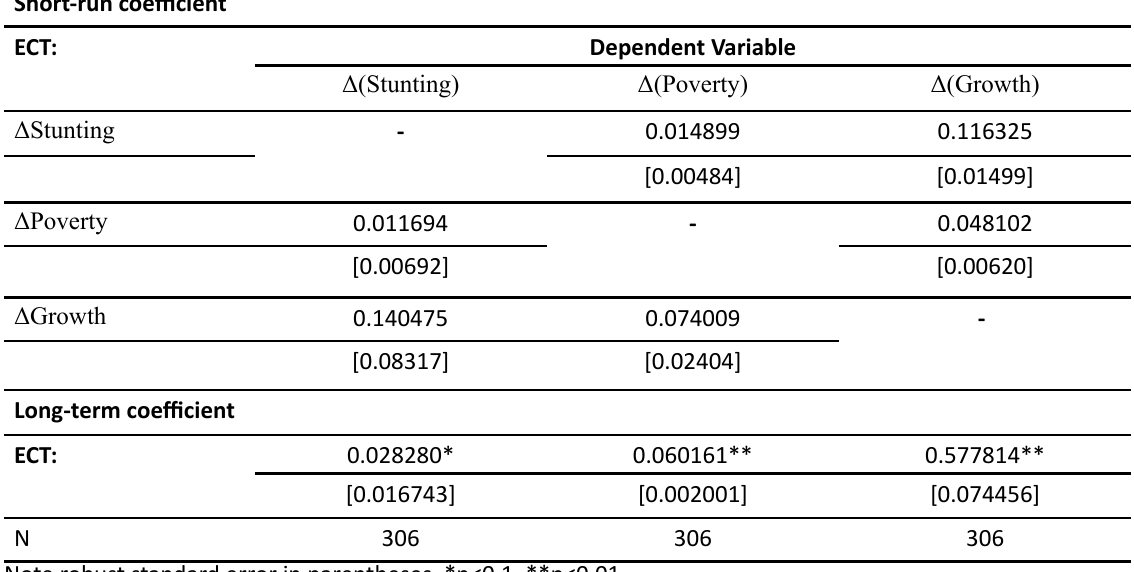
Table 6: Vector Error Correction